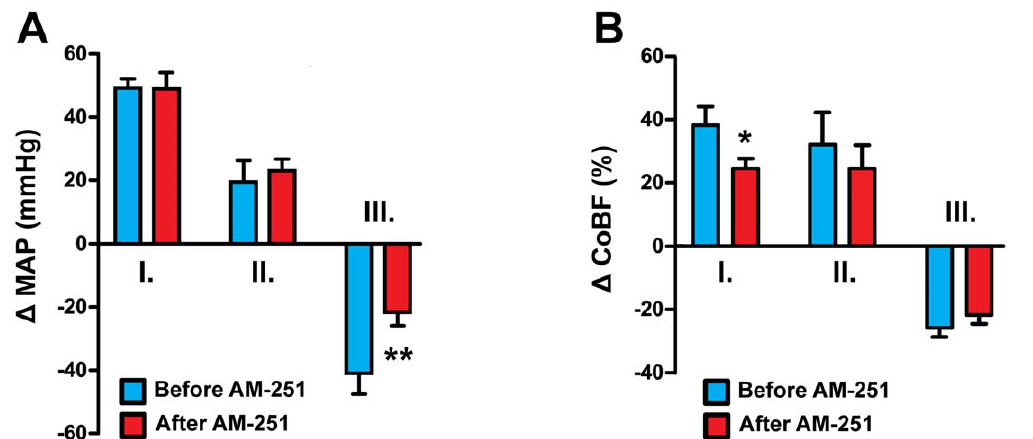
Figure 3. Effects of AM-404 on mean arterial pressure (A) and cerebrocortical blood flow (B) before and after AM-251 treatment. Changes in mean arterial pressure (MAP, n=10) and cerebrocortical blood flow (CoBF, n=20) are shown in phases I, II and III of the AM-404 (10 mg kg 2 1 , i.v.) response before and after treatment with AM-251 (10 mg kg 2 1 , i.v.). Values are means 6 SEM and are expressed as changes from baseline (see Table 2); *P , 0.05, **P , 0.01, versus ‘‘Before AM-251’’.